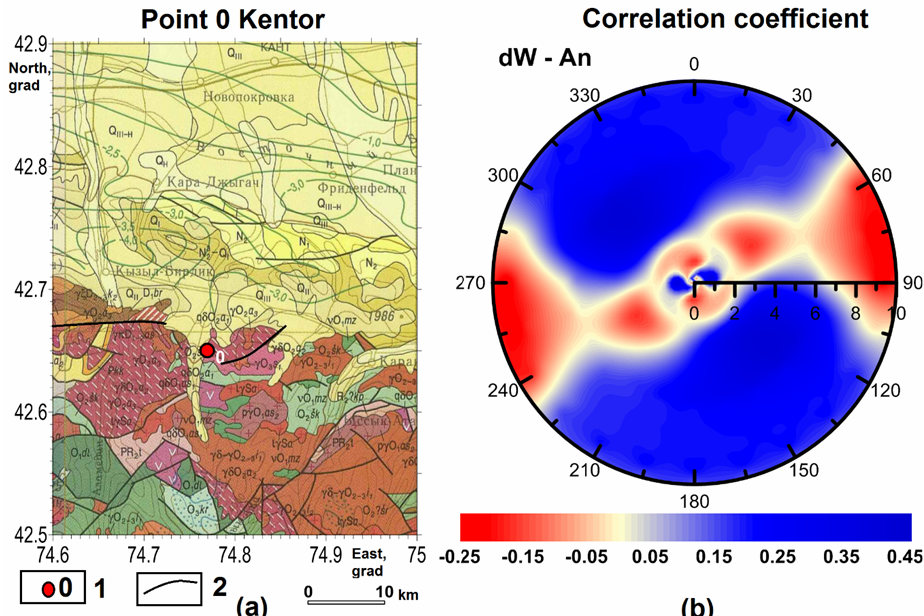
Figure 2. Correlation polar diagrams for the Kentor mini-poligon: a) - location of monitoring points and faults: 1 - local faults, 2 - MT-monitoring point; b) сorrelation diagrams for variations of Wiese vectors (dW) at FT-0 and: by the vertical component of lunar-solar tidal effects (An). Taking into account that real induction arrows (Re W ) are associated with active electric currents, and imaginary (Im W ) - with reactive ones, we built and considered the time-frequency series of both parameters (Re W and Im W ). The experimental results obtained indicate that the position of the clusters on the polar correlation diagrams (Fig.